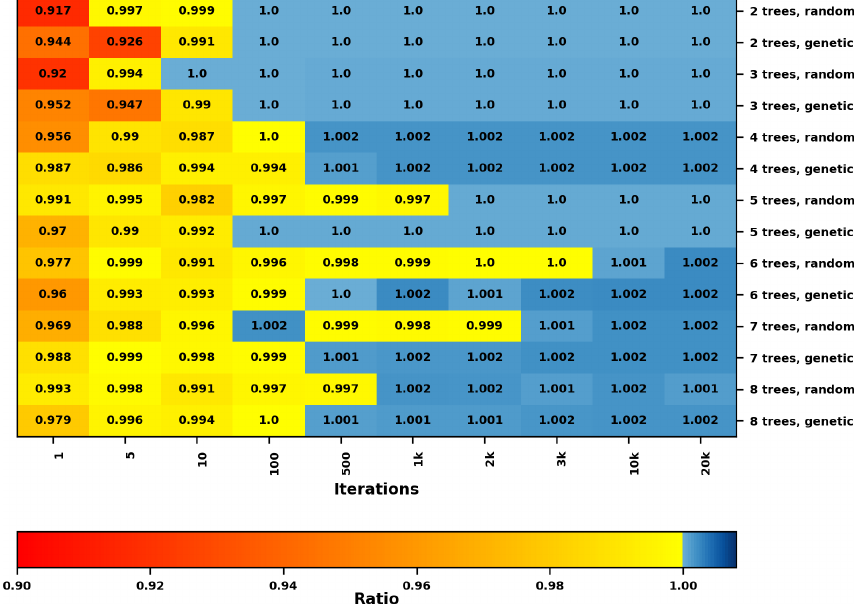
Figure 8. Heat map showing the ratio of potential decrease in T mrt between the hill-climbing algorithm and the greedy algorithm for two, three, four, five, six, seven and eight large (Table 1) trees for different numbers of model iterations, for 13:00–16:00LST on 22 June 1983. Two starting algorithms were used: random and genetic. There are 1481 potential locations for trees. A ratio > 1 indicates a larger potential decrease with the hill-climbing